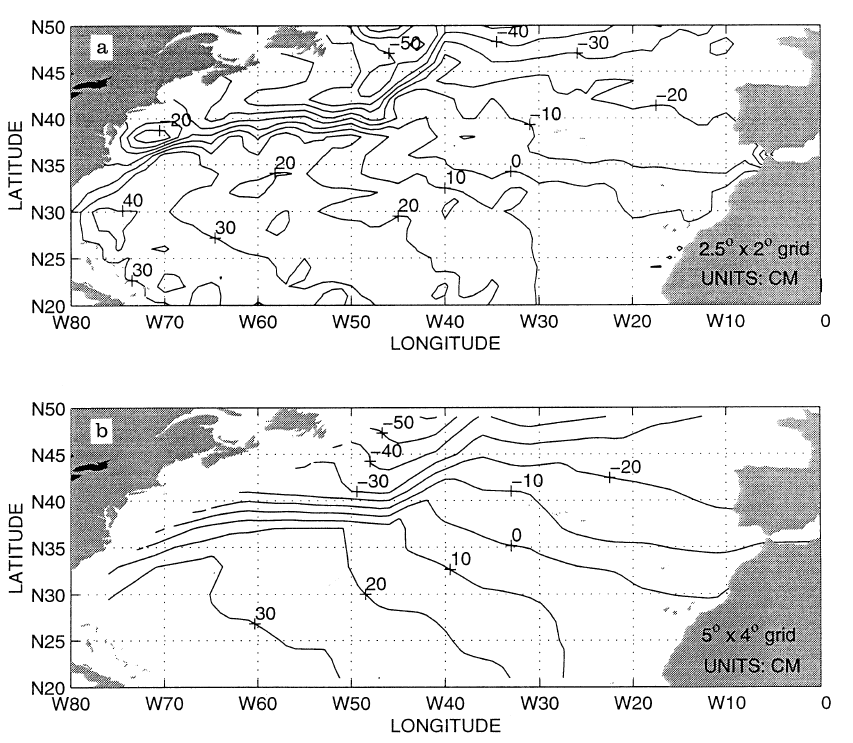
Fig. 4. a Mean dynamic topography (cm) diagnosed from the density field on the 2.5 (cid:176) longitude (cid:180) 2 (cid:176) latitude grid. b Same as a but averaged onto the 5 (cid:176) longitude (cid:180) 4 (cid:176)